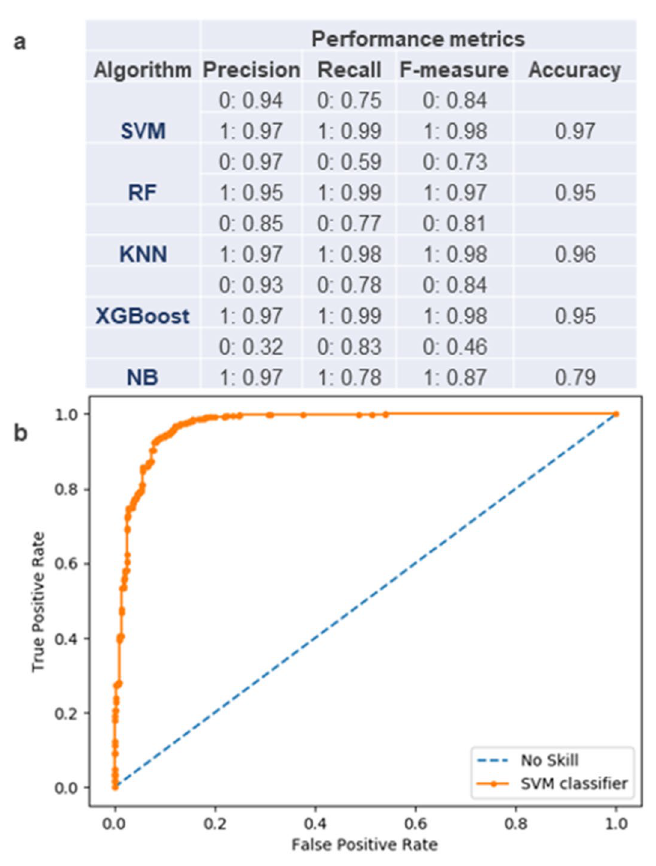
Figure 3. Performance evaluation of machine-learning algorithms for pre-miRNA identification. ( a ) Performance metrics are provided for the five tested algorithms: SVM, Support Vector Machine; RF, Random forest; KNN, K-Nearest Neighbors; XGBoost and NB, Naïve Bayes. Precision, Recall and F-measure values are calculated for classifying negative (0) and positive (1) test data to expected classes. ( b ) ROC (receiver operating characteristic) curve for the trained SVM